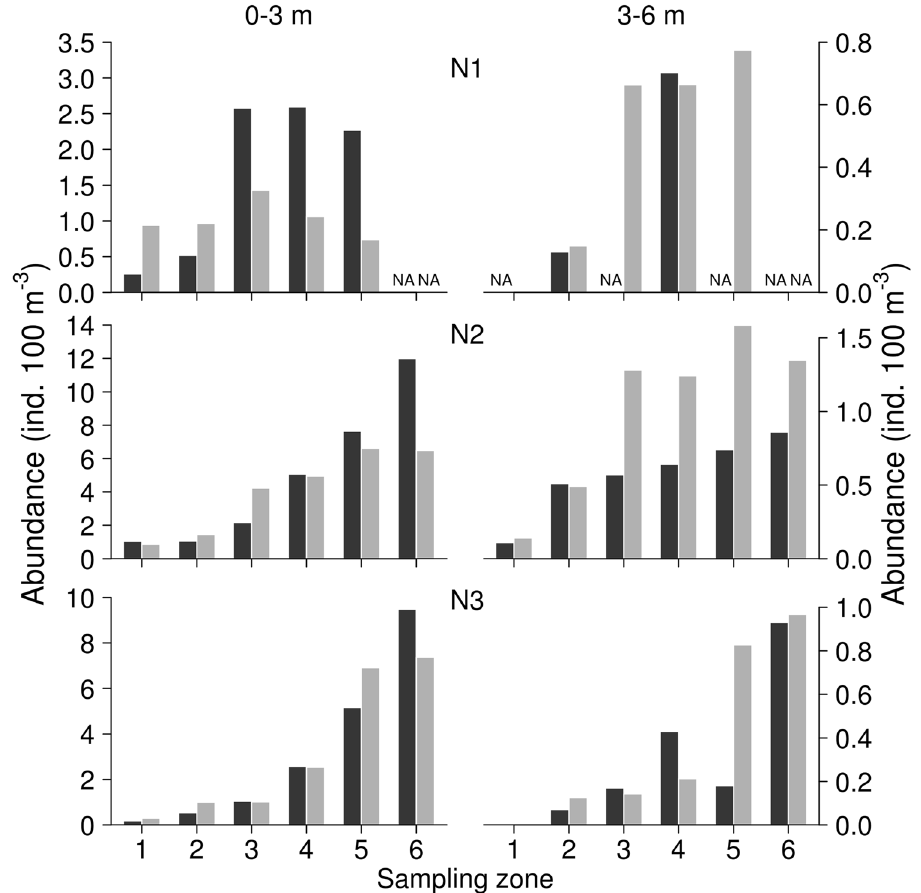
Figure 3. Abundance of juvenile fish on each night (N1–N3, 38 kHz). In each zone (1–6) and in 0–3 m (upstream cruise) and 3–6 m (downstream cruise) sampled by trawling (black) and upward-looking (grey). NA – not